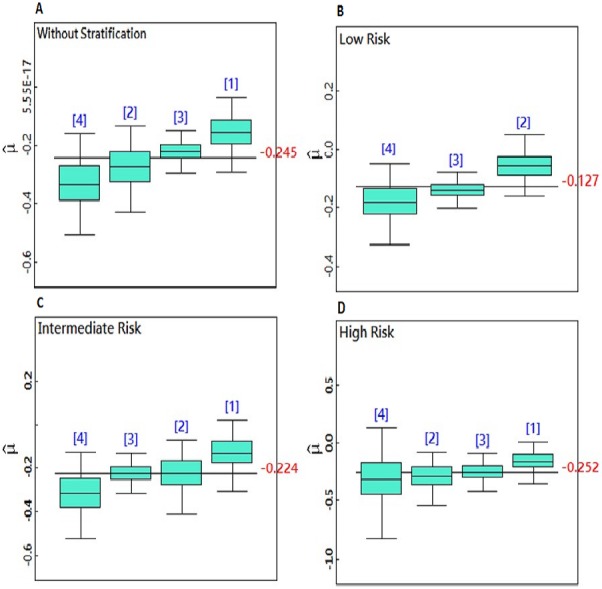
(A–D) Boxplots for comparison of the dose level posterior means in the non-stratified and stratified patients.